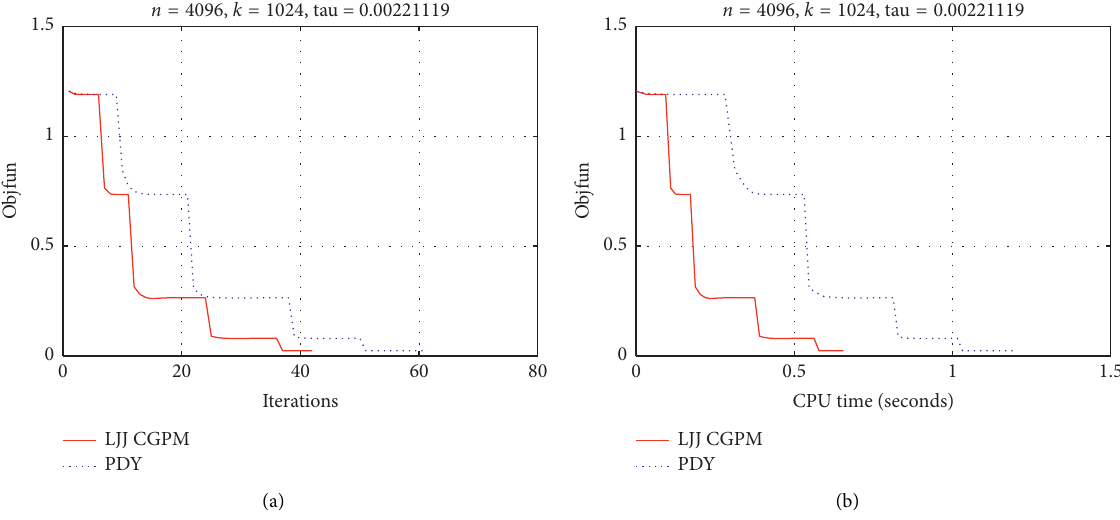
Figure 6: Plots of the objective function value versus iteration and CPU